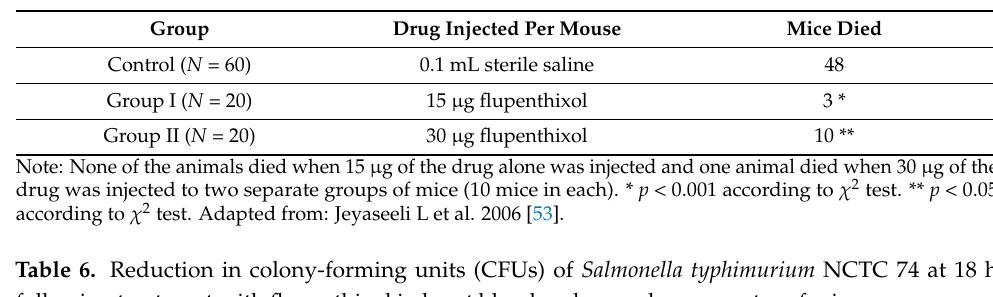
Table 5. Determination of the in vivo protective capacity of flupenthixol in mice receiving a challenge dose of Salmonella typhimurium NCTC 74 in 0.5 mL nutrient broth.